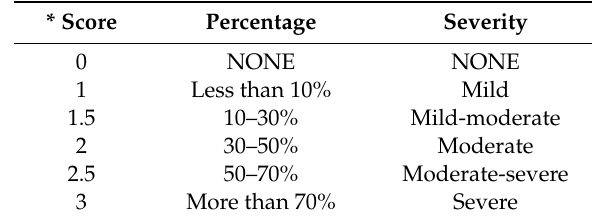
Table 12. Interpretation of scores in liver and kidney lesion scoring for the toxicity studies of CELE in ICR